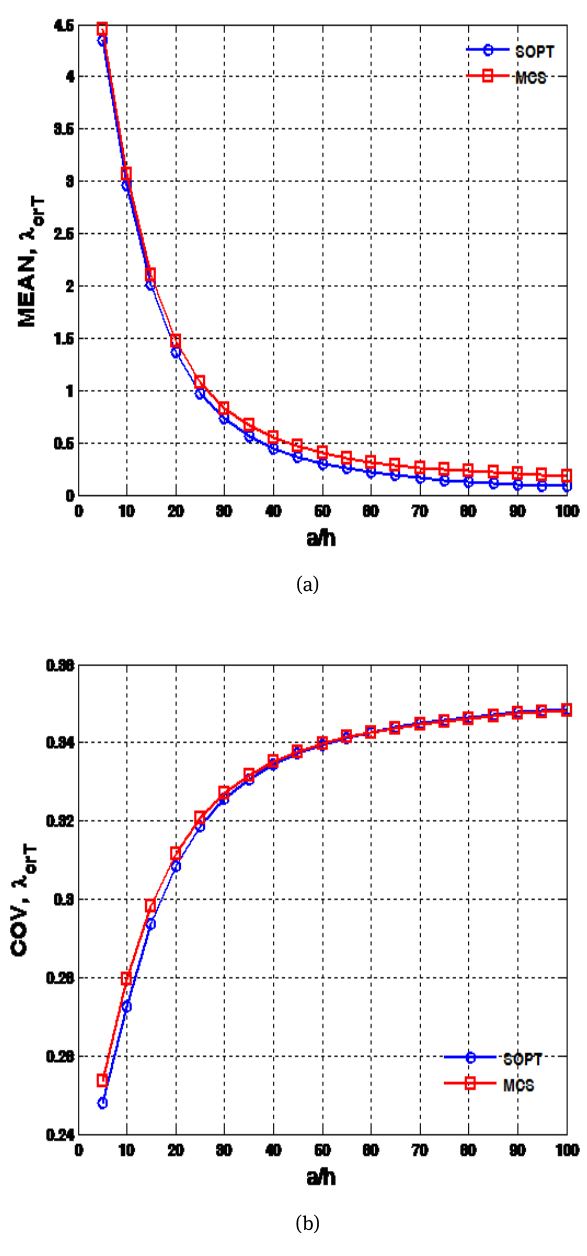
Figure 4: The validation study of mean and COV of buckling temper- ature of laminated square clamped laminated composite plate by varying different a/h ratios using SOPT and